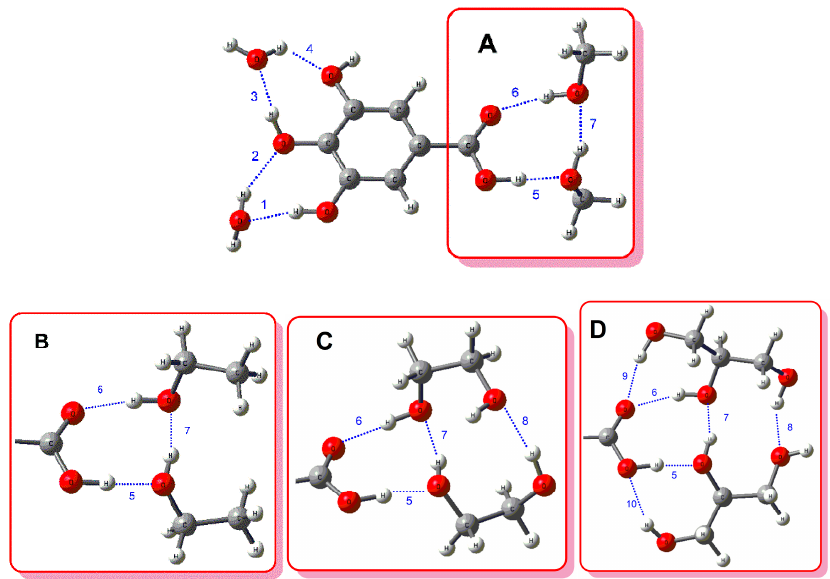
Figure 2. Optimized structures at density functional theory (DFT) M06-2X/6-311+G(d,p) level for gallic acid and water with methanol ( A ); ethanol ( B ); ethylene glycol ( C ); and glycerol ( D ). Table 2. Calculated distances, and stabilization energies for the hydrogen bonds between gallic acid, water and methanol ( A ); ethanol ( B ); ethylene glycol ( C ); and glycerol ( D ). Hydrogen bond Distances (Å)